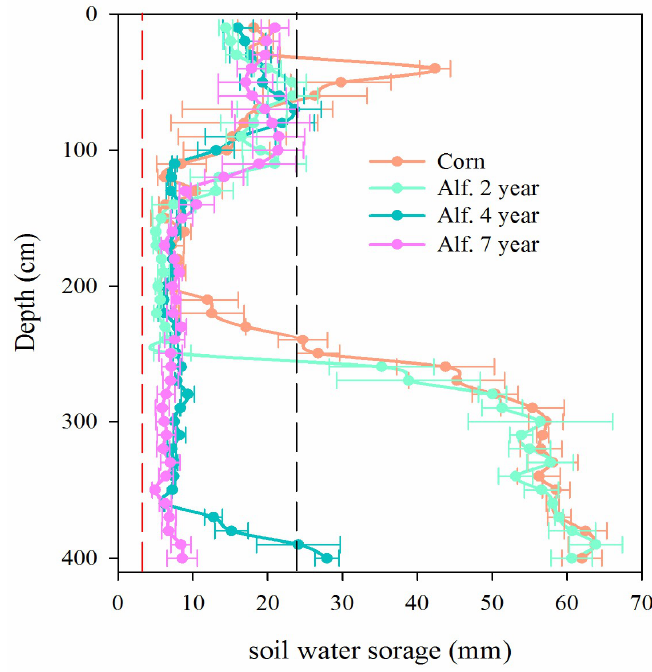
Figure 2. Soil water storage in the cornfield and in the two-, four- and seven-year-old alfalfa pastures in the 0–400 cm soil layers at 10 cm intervals. The black dotted line indicates the soil water content at field capacity. The red dotted line indicates the soil water content at permanent wilting point.